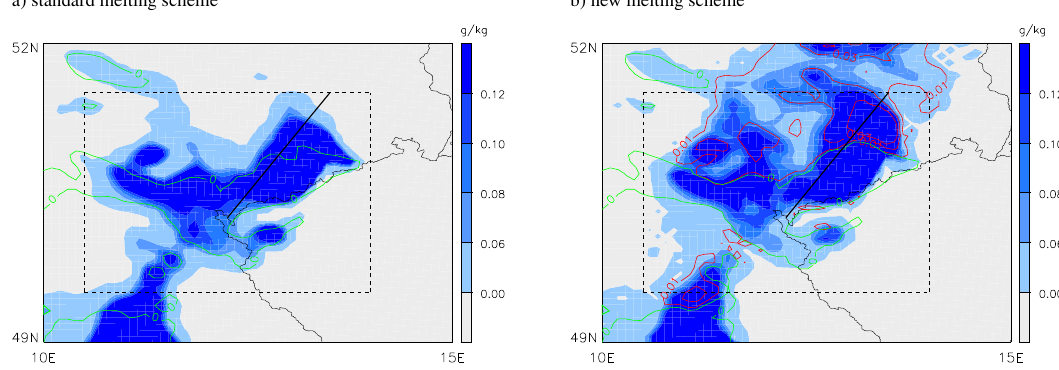
Fig. 5. Snow mixing ratio (colors, in gkg − 1 ), meltwater mixing ratio (red contours, in gkg − 1 , only in panel (b)), and the 0 ◦ C isoline (green contour) on model level 8 at 14 UTC 16 November 2010 for the simulations with (a) the standard and (b) the new snow melting scheme. The dashed box marks the main area of interest while the black line indicates the location of the vertical cross sections shown in Figs. 6 and 7a.